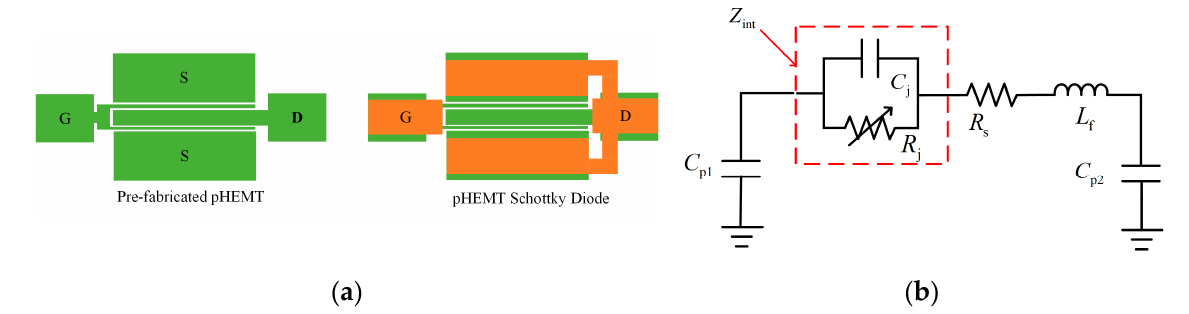
Figure 2. ( a ) The GaAs pHEMT diode layout; ( b ) the GaAs pHEMT diode model. In the design process, the gate length of the Schottky diode in the process is fixed, while the single-finger gate width W and the number of gates N are variable. Schottky diodes with different numbers and widths of gates have different impedance, noise, power and gain characteristics, which need to be selected depending on the application and desired frequency range [24]. The I-V curves of diodes with different gate numbers and widths and are shown in Figure 3, where the current axis is logarithmic. The simulation and test data of a two-finger 20 µ m diode deviate slightly for voltages below 0.1 V, and the other values are in good agreement, which is indicative of the diode model’s accuracy. For diodes with different sizes, DC parameters such as I s , n and R s are extracted through their I-V curves [26].